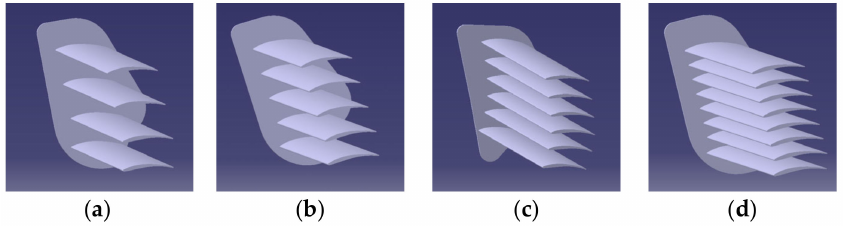
Figure 17. CAD models of additional simulation cases. ( a ) Shutters with number of fin n = 4. ( b ) Shutters with number of fin n = 5. ( c ) Shutters with number of fin n = 6. ( d ) Shutters with number of fin n = 8.